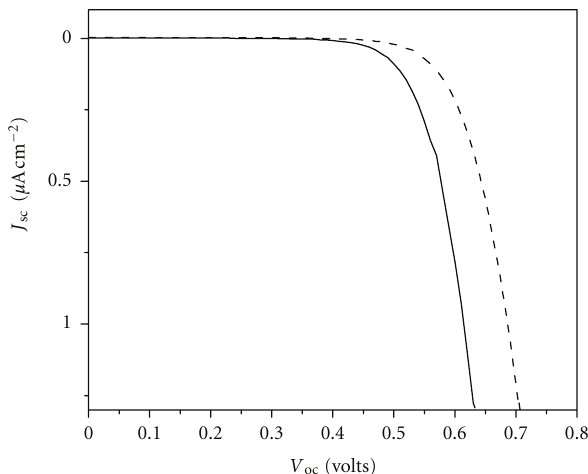
Figure 3: Dark current-voltage curves of DSCs using TiO 2 obtained by the acid (—) or alkaline (---) routes.